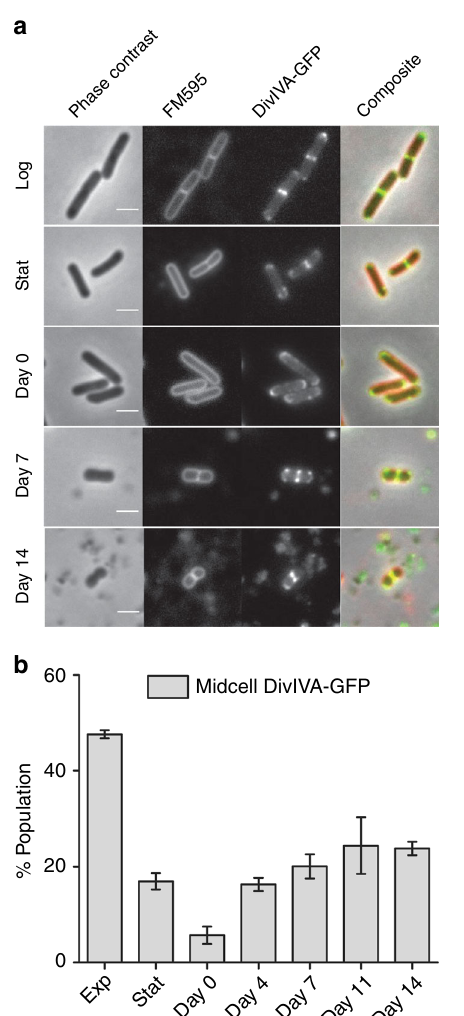
Fig. 6 Presence of cell division sites. B. subtilis Δ spoIIE cells encoding divIVA- gfp reporter were incubated for 14 days in starvation buffer. a At different time intervals samples were taken for microscopic analysis. Cells were stained with the fl uorescent membrane dye FM5 – 95. Scale bar is 2 µ m.